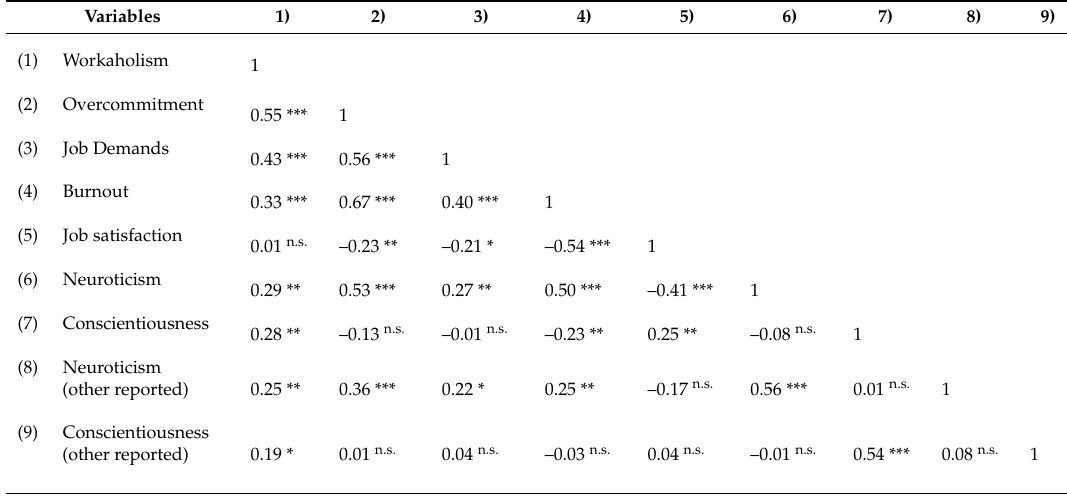
Table A1. Full zero-order correlation